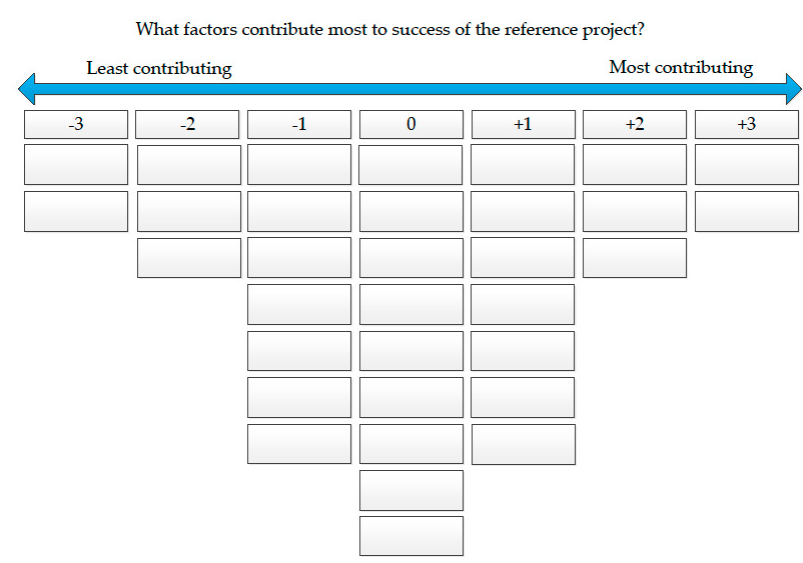
Figure 1. Score sheet for Q-sorting.